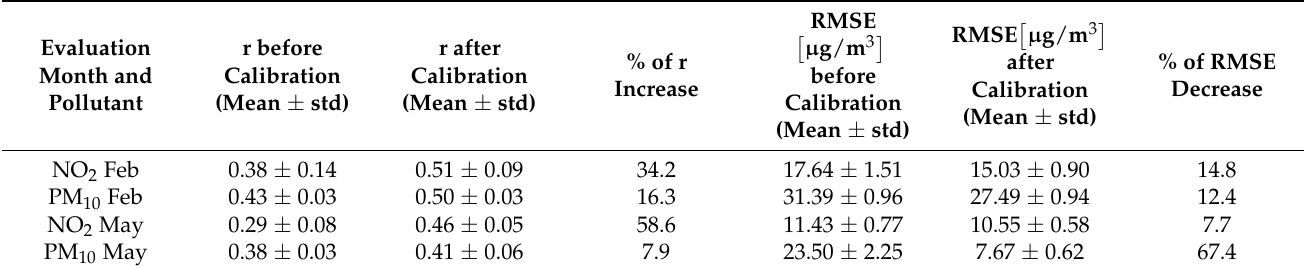
Table 6. The summary of the obtained results for all low-cost devices before and after calibration